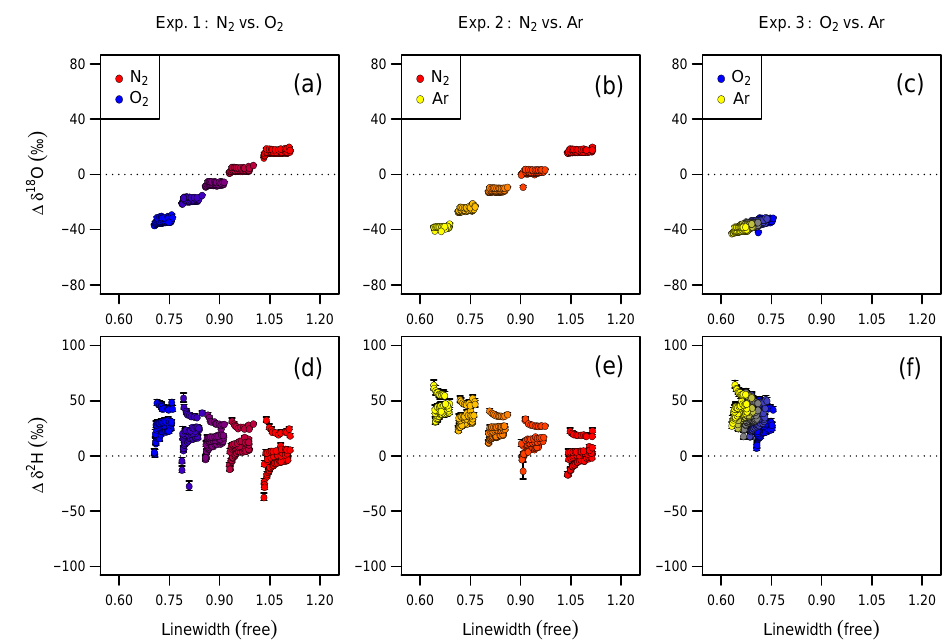
Figure 9. Relationship between the free linewidth parameter, (cid:49)δ 18 O, and (cid:49)δ 2 H values. For each panel, n = 330 measurements of four liquid standards across a range of injection volumes (i.e., 400–2400nL, in 11 steps of 200nL each). Points represent mean values ± SD for replicates of each standard at each injection